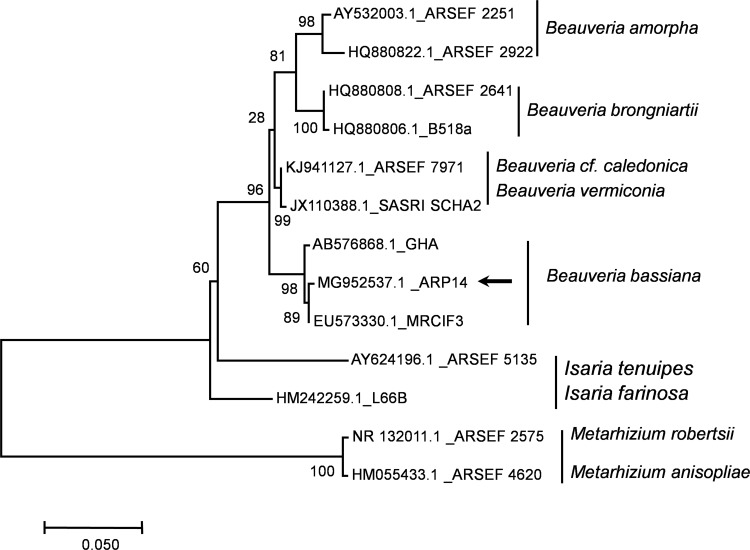
Molecular phylogenetic analysis of Beauveria bassiana ARP14 with similar strain and other genera based on nucleotide sequence and constructed by maximum likelihood method.The analysis involved 13 nucleotide sequences. All positions containing gaps and missing data were eliminated. A total of 438 positions were included in the final dataset. Evolutionary analyses were conducted in MEGA7.